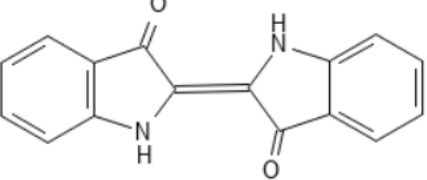
Figure 1. Chemical structure of Vat Blue 1 (indigo).